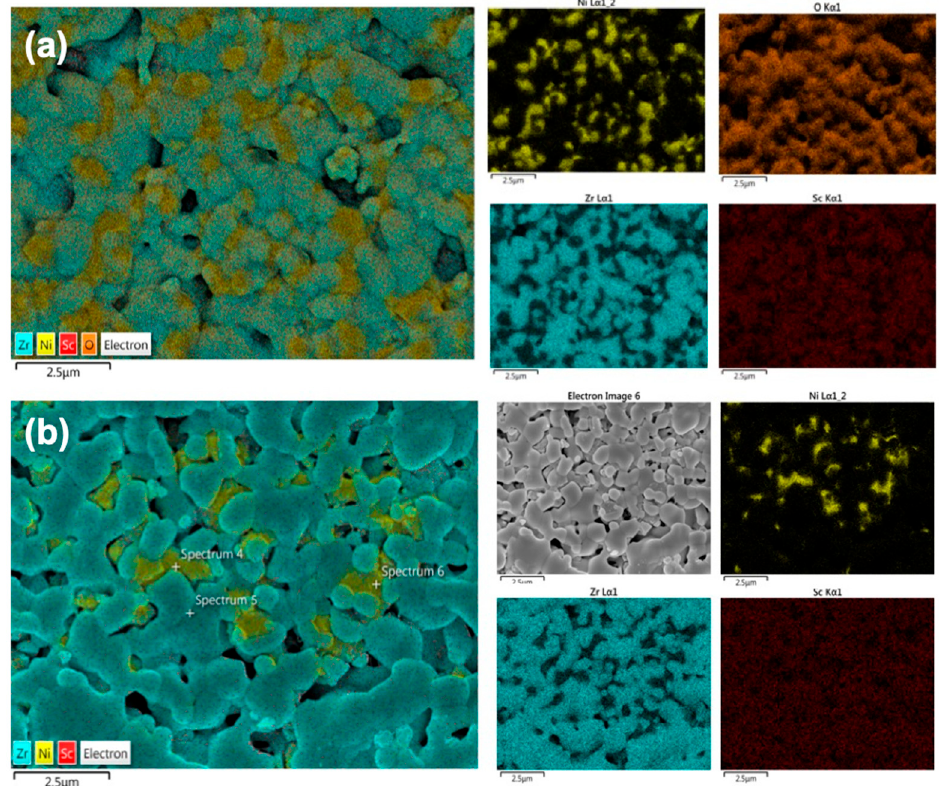
Figure 3. Electron-dispersive spectroscopy (EDS) mapping of as sintered NiO/ScSZ (top images) and reduced Ni/ScSZ (bottom image) for a g/n ratio of 0.27 ,showing the elemental map of Zr, Sc, Ni, and O.